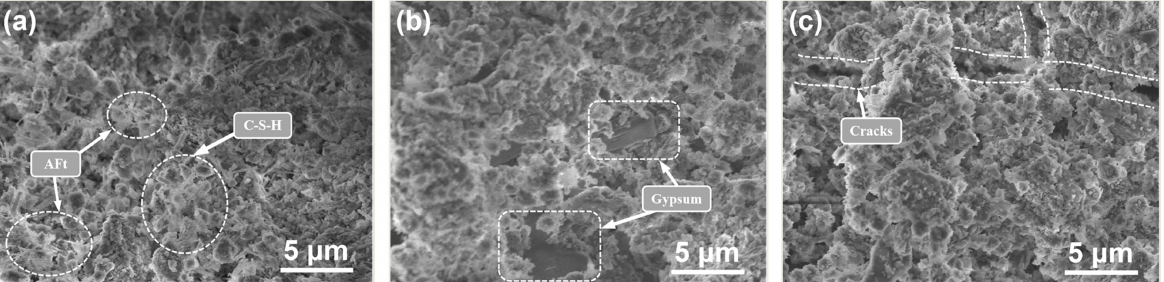
Figure 11. SEM showing erosion produced after the 8th cycle with different concentrations: ( a ) water (DN0); ( b ) 5% Na 2 SO 4 solution (DN5); ( c ) 10% Na 2 SO 4 solution (DN10).